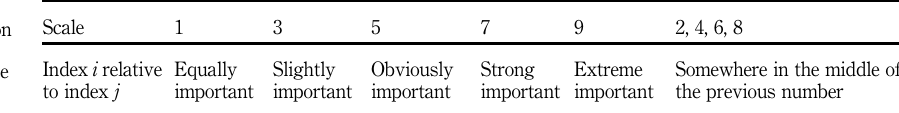
of 1 – 9 quantitative scales of importance of